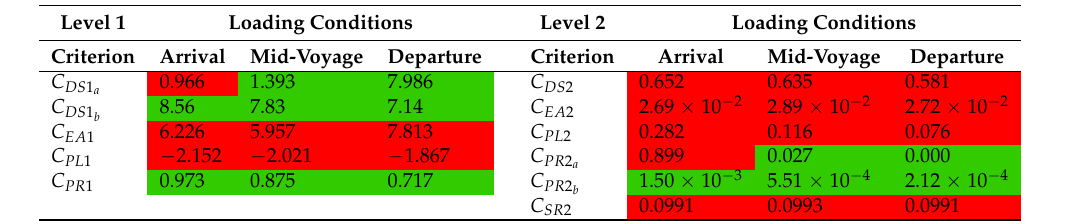
Table 10. Comprehensive assessment of SGISc vulnerability levels for Y01 considering the central Mediterranean Sea. Criteria compliant with the standard are highlighted in green. Criteria not compliant with the standard are highlighted in red.